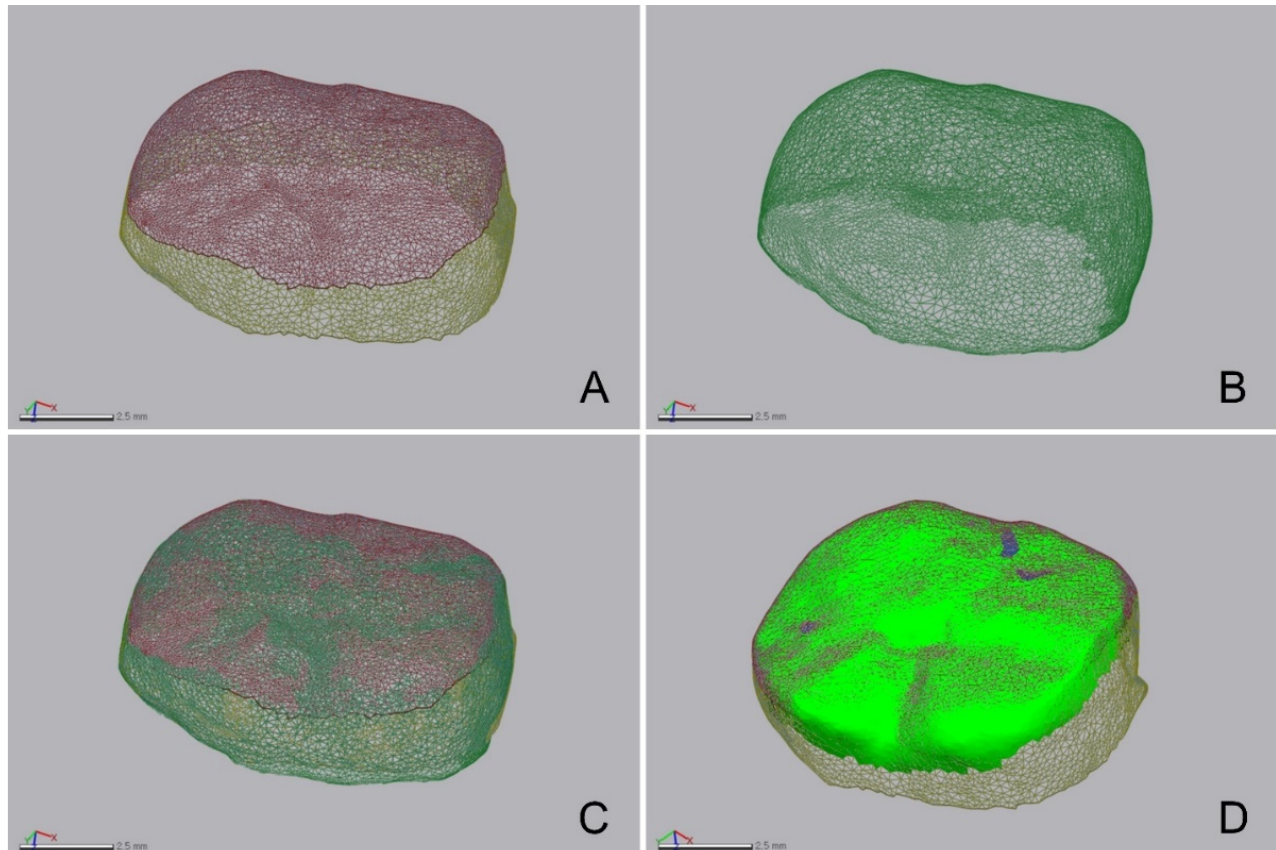
Figure 3. 3D analysis procedure. ( A ) Segmented virtual model of the interim crown before wear. ( B ) Virtual model of the interim crown after wear. ( C ) Superimposition. ( D ) Evaluation of wear on the segmented occlusal surface of ( A ).